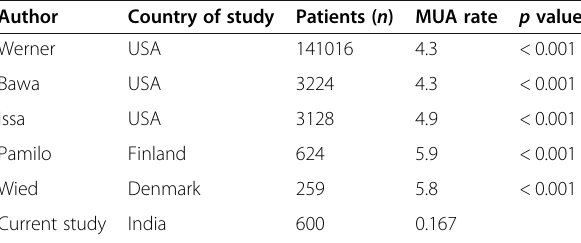
Table 3 MUA rate of current study versus the rates of other large cohorts with p